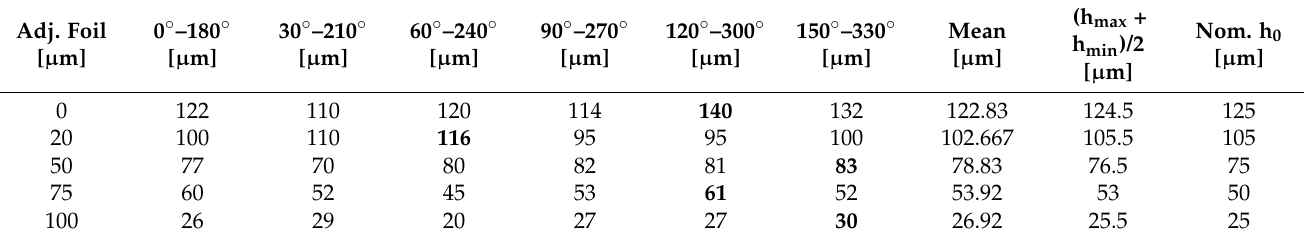
Table 2. Results of the bearing gap measurements for the six bearing configurations. The bold values equal to the measured clearances with the maximum distance to the interval